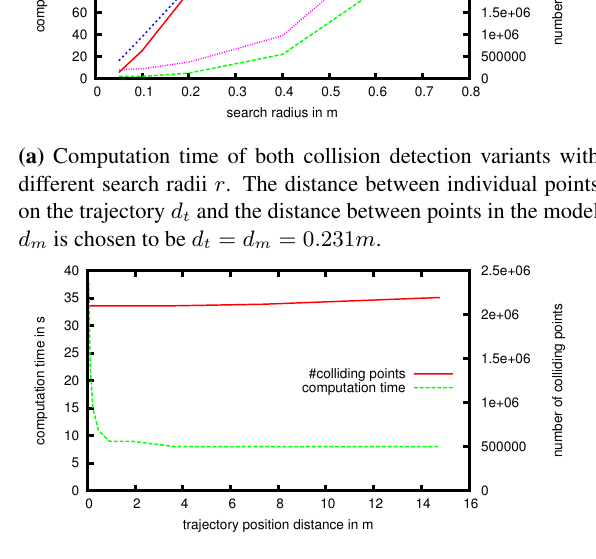
(b) Computation time of the segment based collision detection variant with different distances between individual points on the trajectory with a model sampled with d m = 0 . 231 m and a search radius of 0 . 2 m .